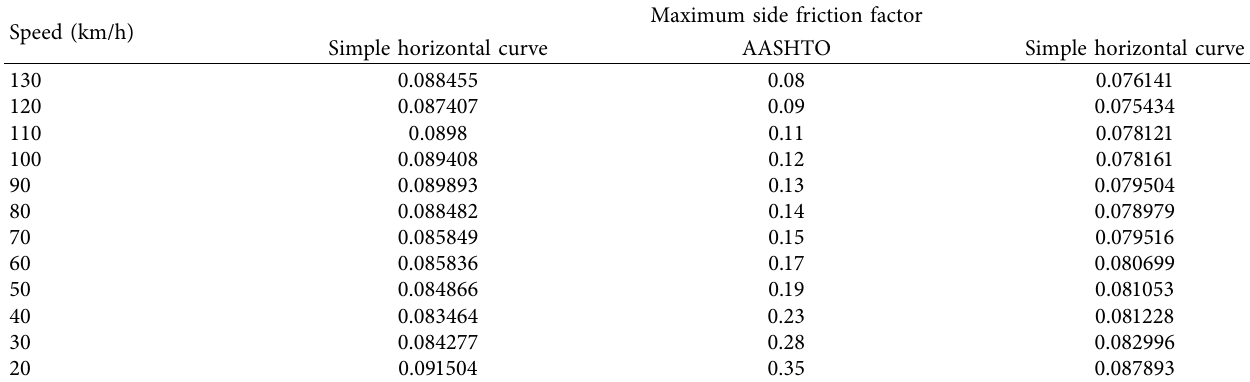
Table 20: Comparison of the maximum side friction factor for SUV between simple and spiral horizontal curves and AASHTO rec- ommended values at a radius of 0.9 R.